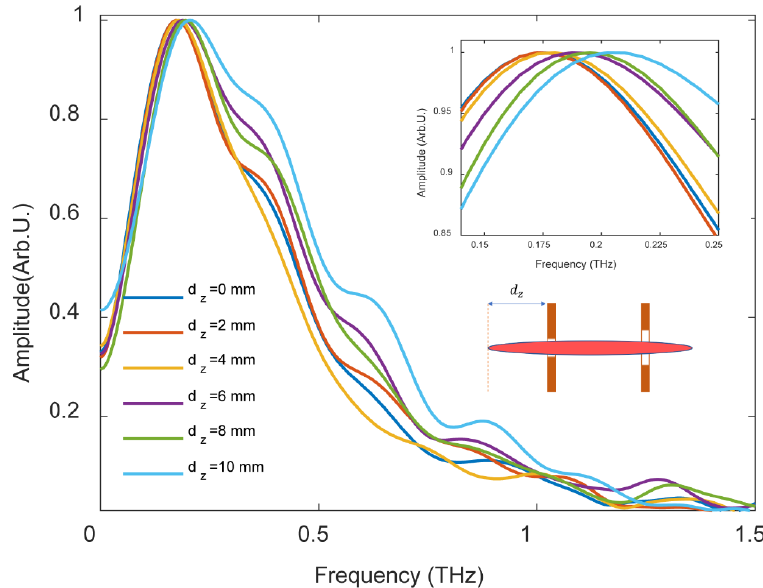
Figure 9. Normalized spectra of radially polarized THz radiation from a dc-biased filament when the location of the electrodes moves from the beginning to the tailing of the filament. The external electric field is 10 kV/cm. The distance from the beginning of the filament to the electrodes is defined as d z , as shown in the figure.